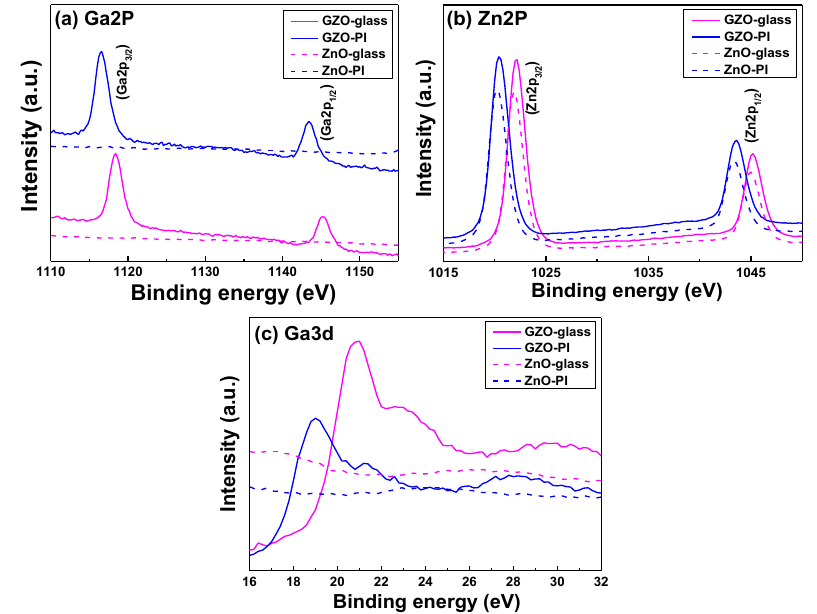
Figure 8. Binding energy spectra of ( a ) Ga2p 3/2 and Ga2p 1/2 peaks; ( b ) Zn2p 3/2 and Zn2p 1/2 peaks; and ( c ) Ga3d peak for the undoped ZnO thin films and GZO thin films on different substrates.